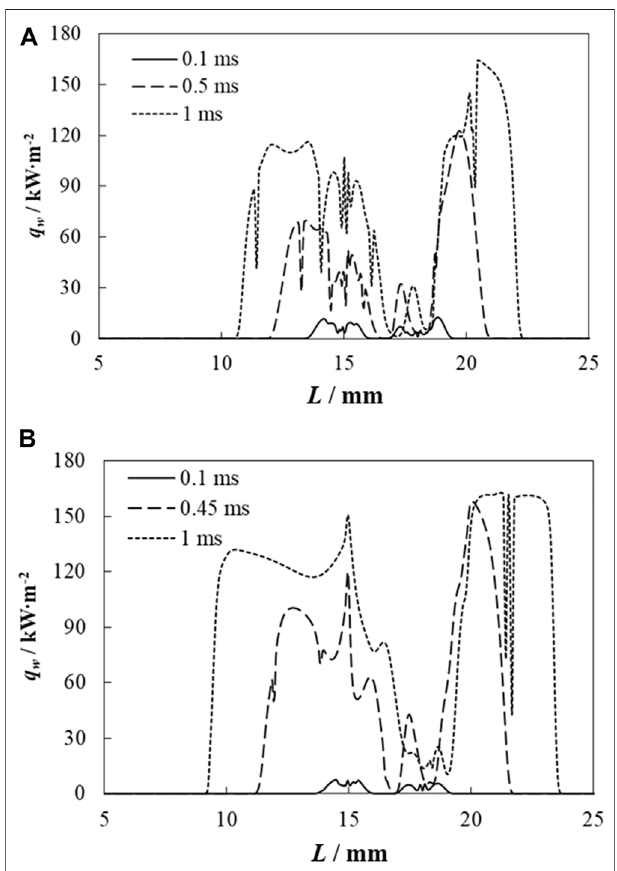
FIGURE 11 | Wall heat fl ux distribution at impact velocities of 6 and 10 m s − 1 : (A) 6 m s − 1 and (B) 10 m s − 1